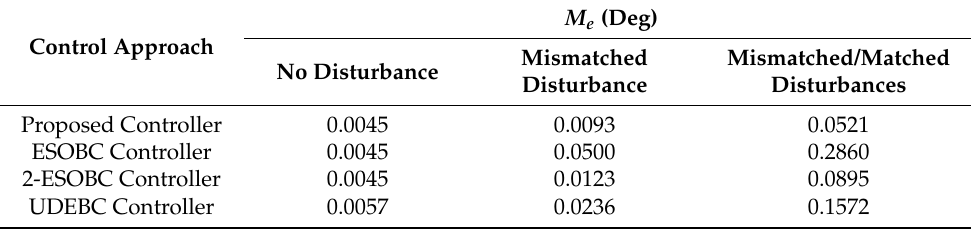
Table 3. The average tracking errors in the steady-state phase.